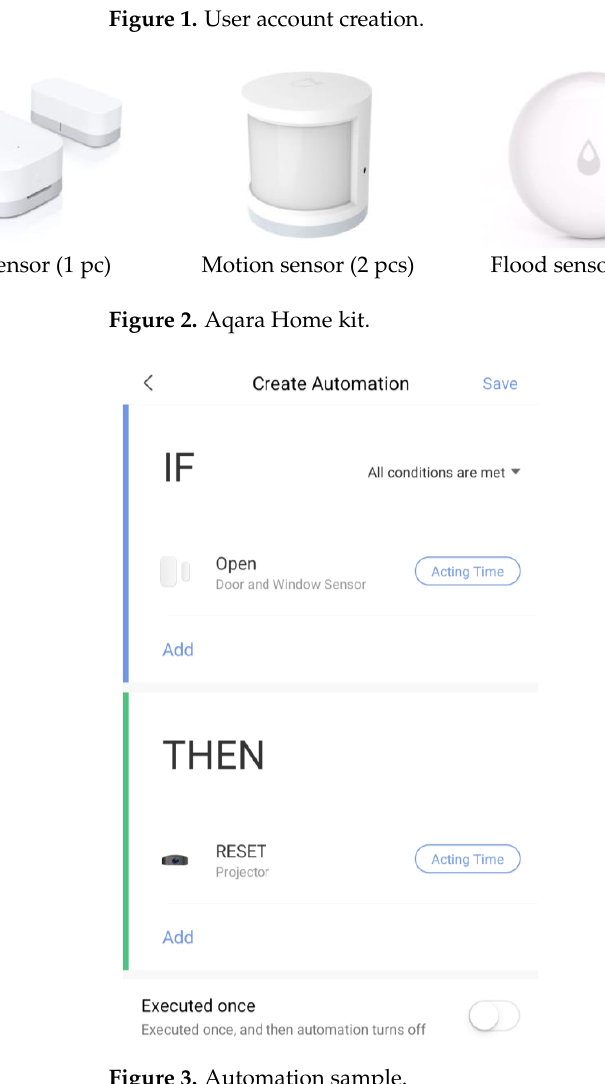
Figure 3. Automation sample.